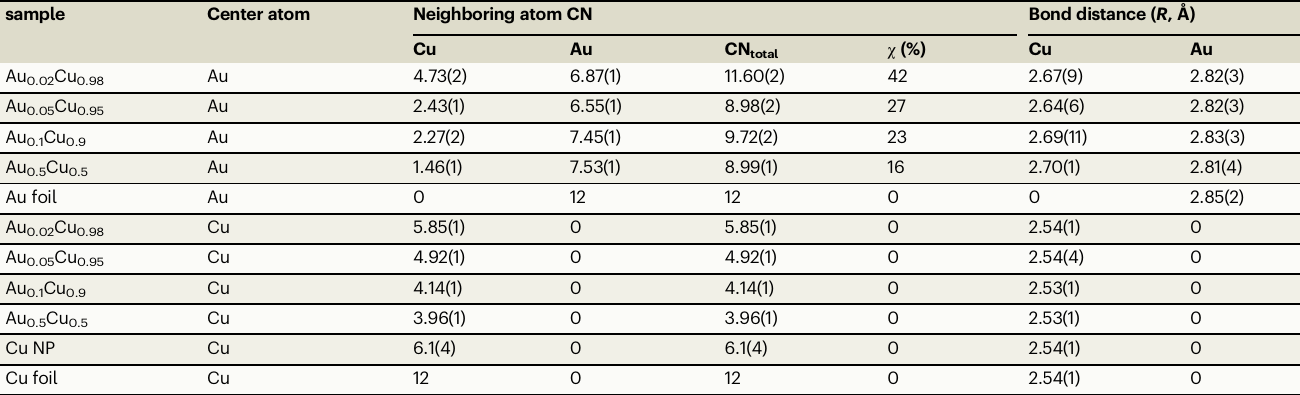
Table 1 | EXAFS fi tting results of Au L 3 _edge and Cu K _edge for Au/Cu 0 nanocubes a